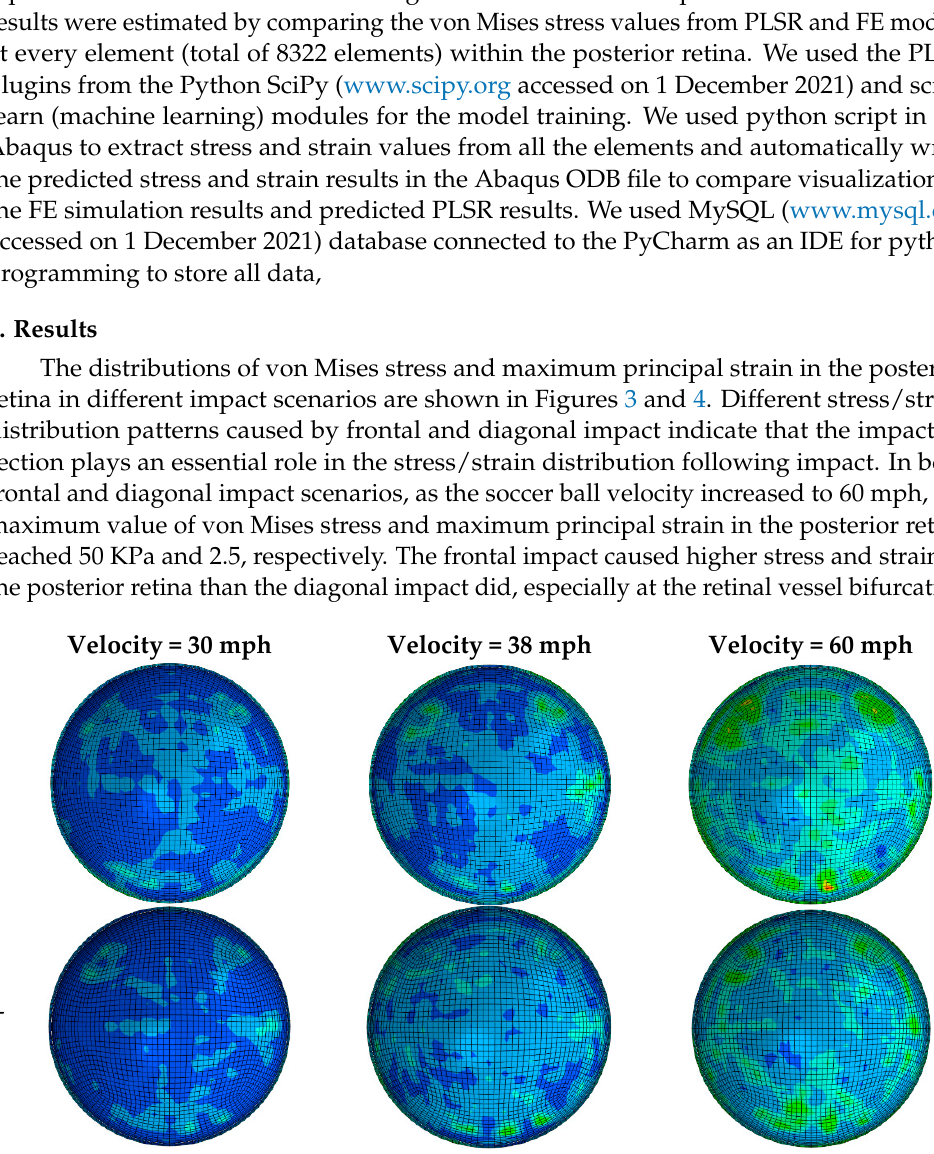
Figure 4. The distribution of maximum principal strain in the posterior retina in frontal and diagonal impact scenarios at three different velocities. The distribution of the von Mises stress predicted by our PLSR-trained model was compared with the FE simulation (Figures 5 and 6) in the scenarios of diagonal impact with a soccer ball velocity of 35 mph and frontal impact with a soccer ball velocity of 65 mph, respectively. Qualitative comparisons of the front, side, and back views showed that the PLSR-trained model captured the overall von Mises stress distribution pattern, includ- ing the locations of the greatest values. The prediction error and relative prediction error of the von Mises stress at each element in the retina are also shown in Figure 6. Only a small portion (less than 5%) of the elements had a relative prediction error larger than 30% due to the low-stress value from FE analysis (nearly 0 value). In addition, our PLSR pre- diction also captured the von Mises stress distribution for a 30-degree impact (Figure 7), an angle which was not included in the training dataset. This illustrates that our model can predict the stress with a new velocity and impact location which had never been seen before by our trained model.